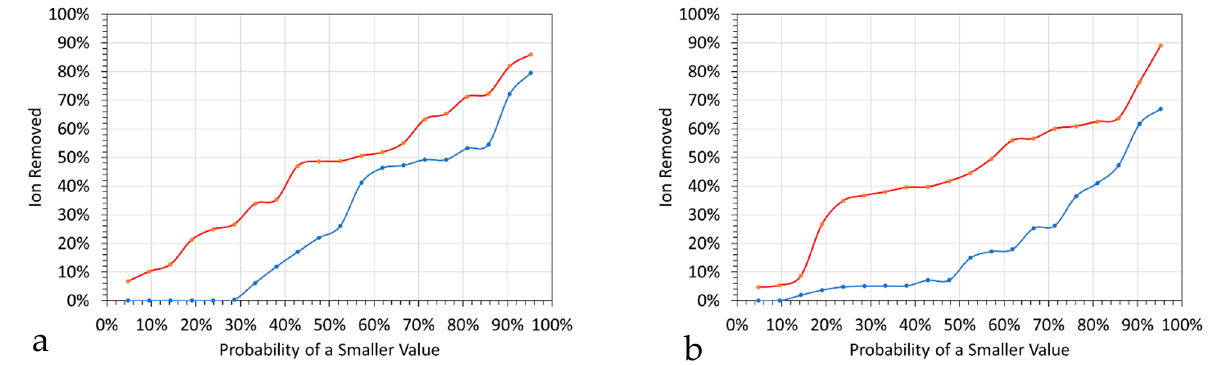
Figure 12. Probability of a smaller value versus percentage of the ion in the feed water which is removed. ( a ), Cl- ion; ( b ), Na+ ion. Blue = undiluted product water >700 h following addition of the polymer and >650 h following separation from the bulk of the settled polymer. Red = diluted product water following >700 storage prior to dilution.